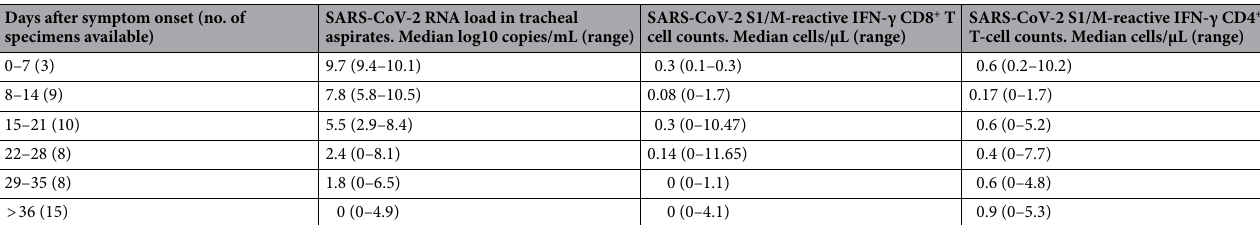
Table 2. Kinetics of SARS-CoV-2 RNA load in tracheal aspirates and SARS-CoV-2 S1/M-reactive IFN-γ CD8 + and CD4 + T cells in paired whole blood specimens from critically ill